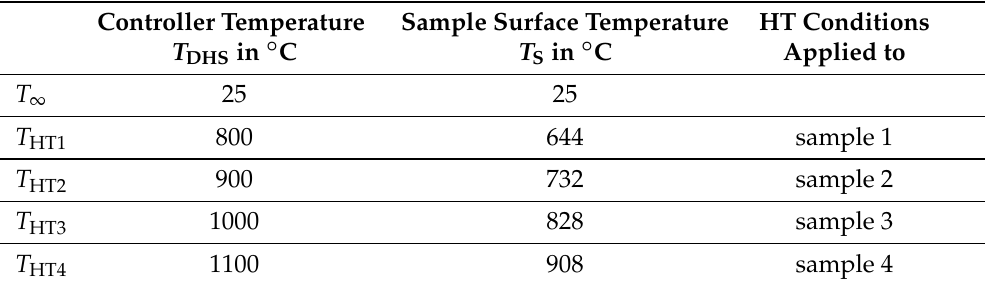
Table 1. Recordings of the steady state temperatures measured in the reference set-up at the controller and the sample’s